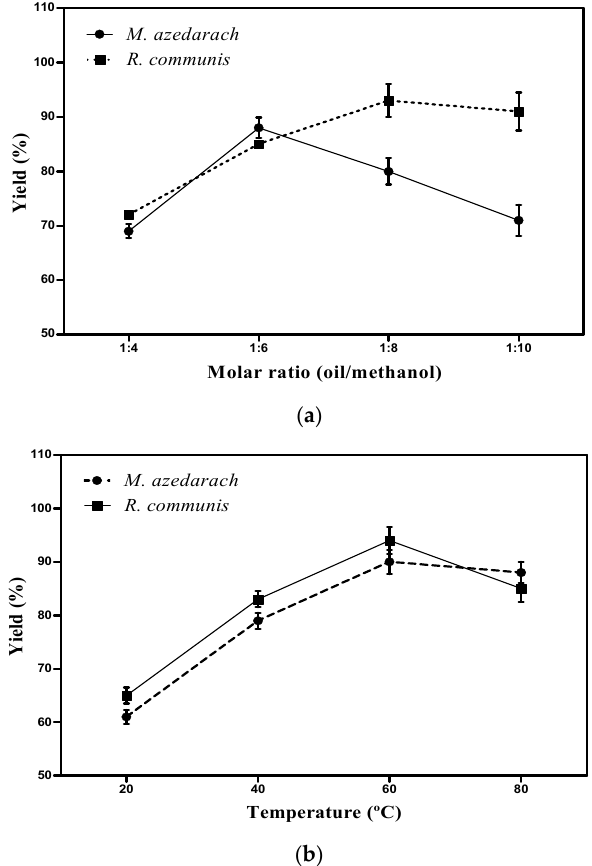
Figure 2. Conversion of oil into biodiesel ( a ) Effect of oil/methanol molar ratio on biodiesel yield ( b ) Effect of varying temperature on biodiesel yield.